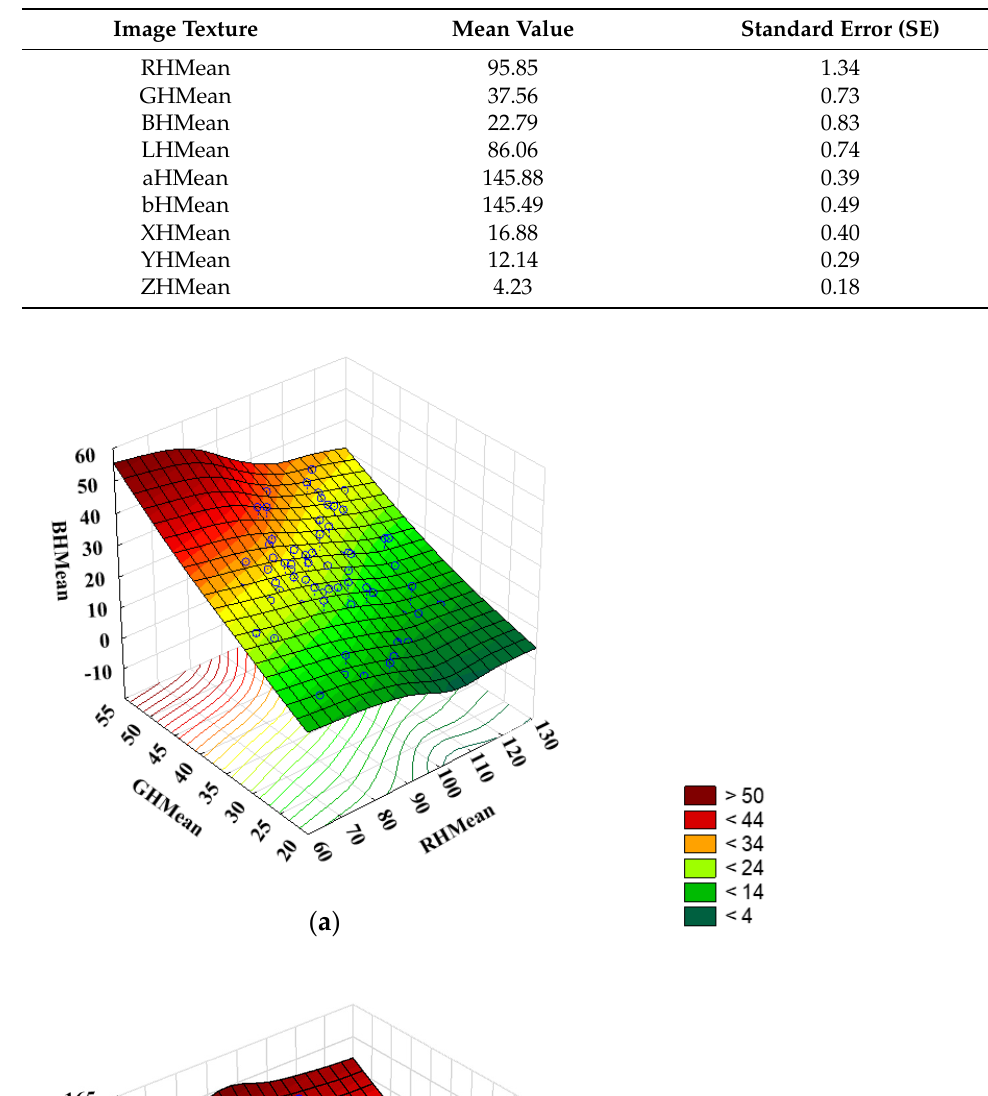
Table 1. Mean values of selected image texture parameters of ‘Mejhoul’ date fruit.